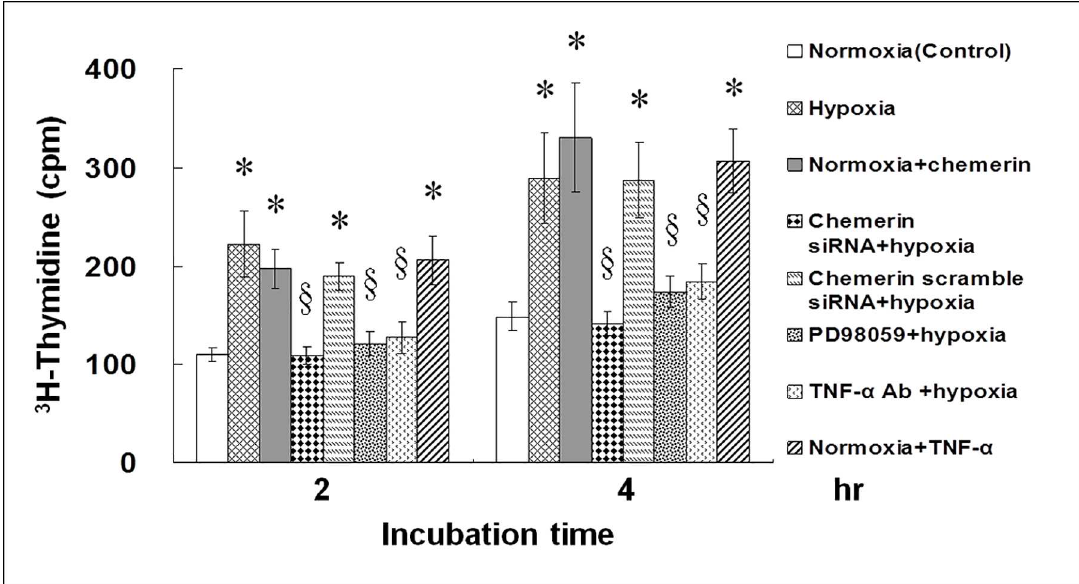
Fig 5. Hypoxia increasesproliferation of HCAECs. Incorporation of [ 3 H]thymidine into HCAECs increasedduring 2.5% O 2 hypoxia and after addition of exogenouschemerinor TNF-alpha during normoxia for 2 to 4 h. Hypoxia-induced incorporation of [ 3 H]thymidine into HCAECs was suppressed by chemerin siRNA, PD98059, or by the anti-TNF-alpha antibody (Ab; n = 4 per group); * p < 0.01 compared to control, § p < 0.01 compared to hypoxia. Cpm: counts per